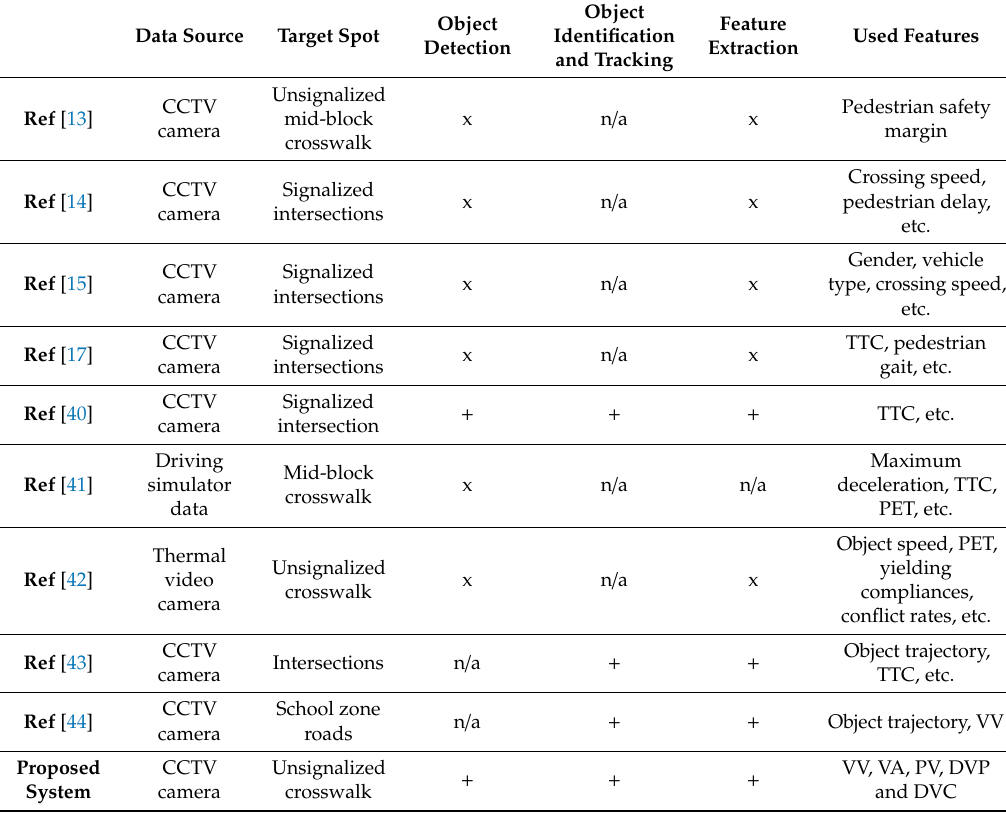
Table 5. Comparison table for characteristics of previous systems with our